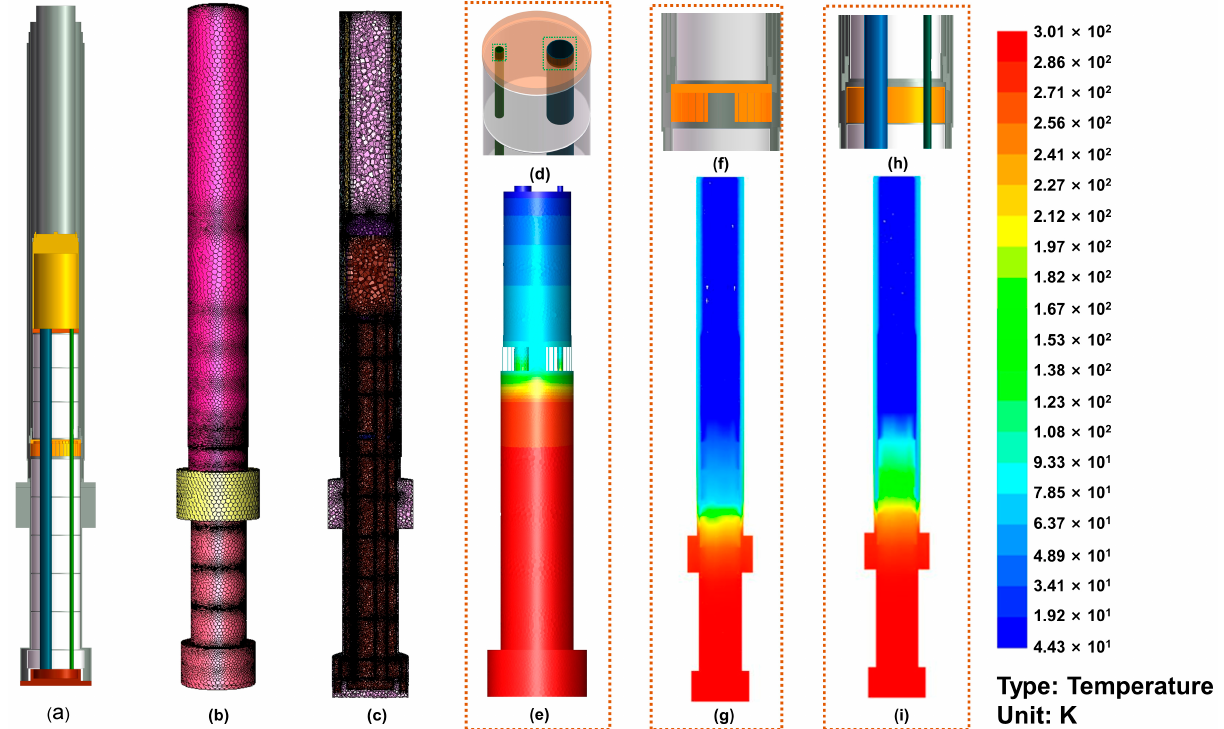
Figure 3. ( a ) Cross-sectional view of the simplified three-dimensional structure. ( b , c ) Meshing of the model in ( a ) in ANSYS. ( d ) The top copper plate section of the MRSI. ( e ) Temperature distribution of the MRSI. ( f ) Cross-sectional view of the simplified model of flexible copper shielding strip. ( g ) Temperature distribution for the model of image ( f ). ( h ) Cross-sectional view of the simplified model after replacing the flexible copper shield strip with a conventional copper shield. The conventional copper shield is not in contact with the liquid N 2 . ( i ) Temperature distribution for the model of image ( h ).